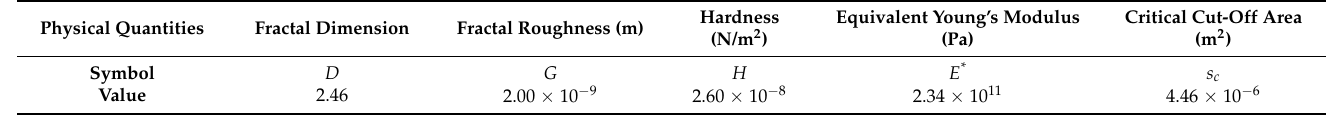
Table 1. Some physical values of the example materials.